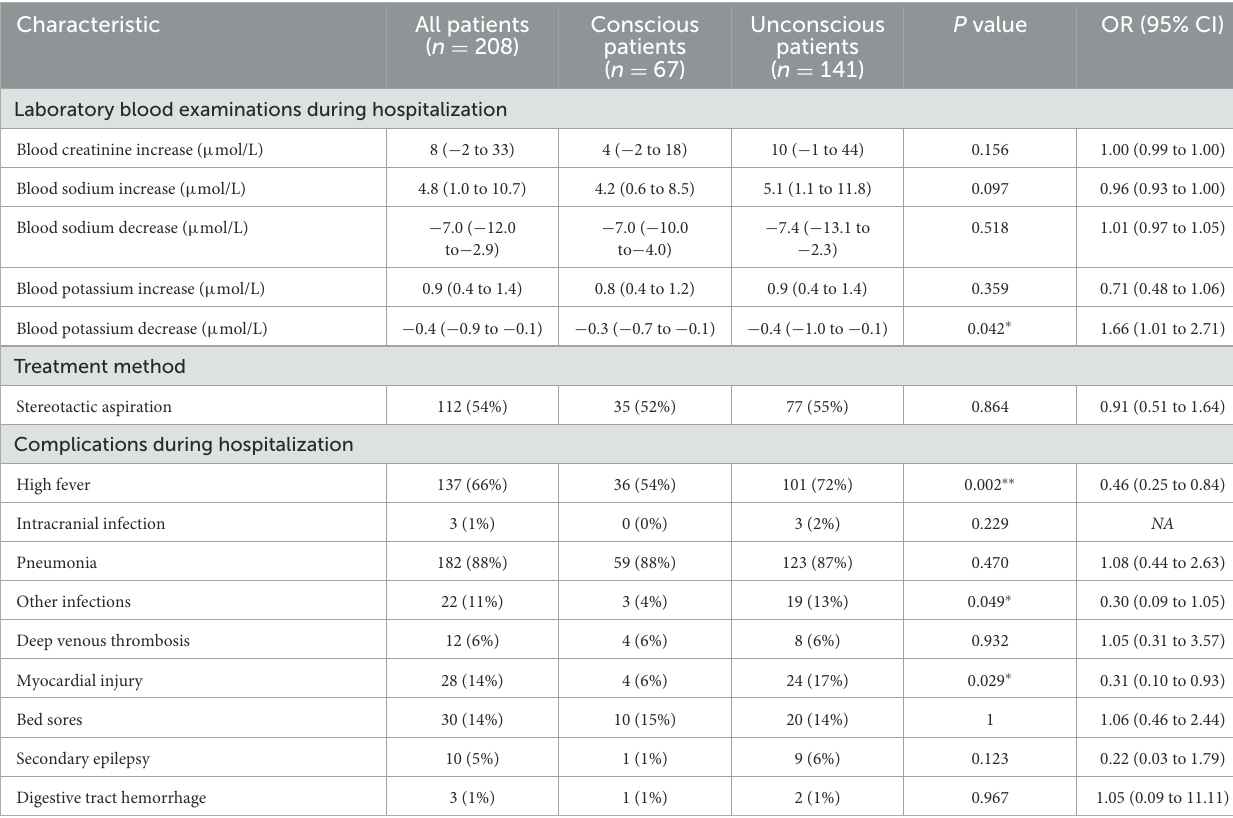
TABLE 3 Associations of characteristics during hospitalization with 90-day consciousness. Characteristic All patients ( n =